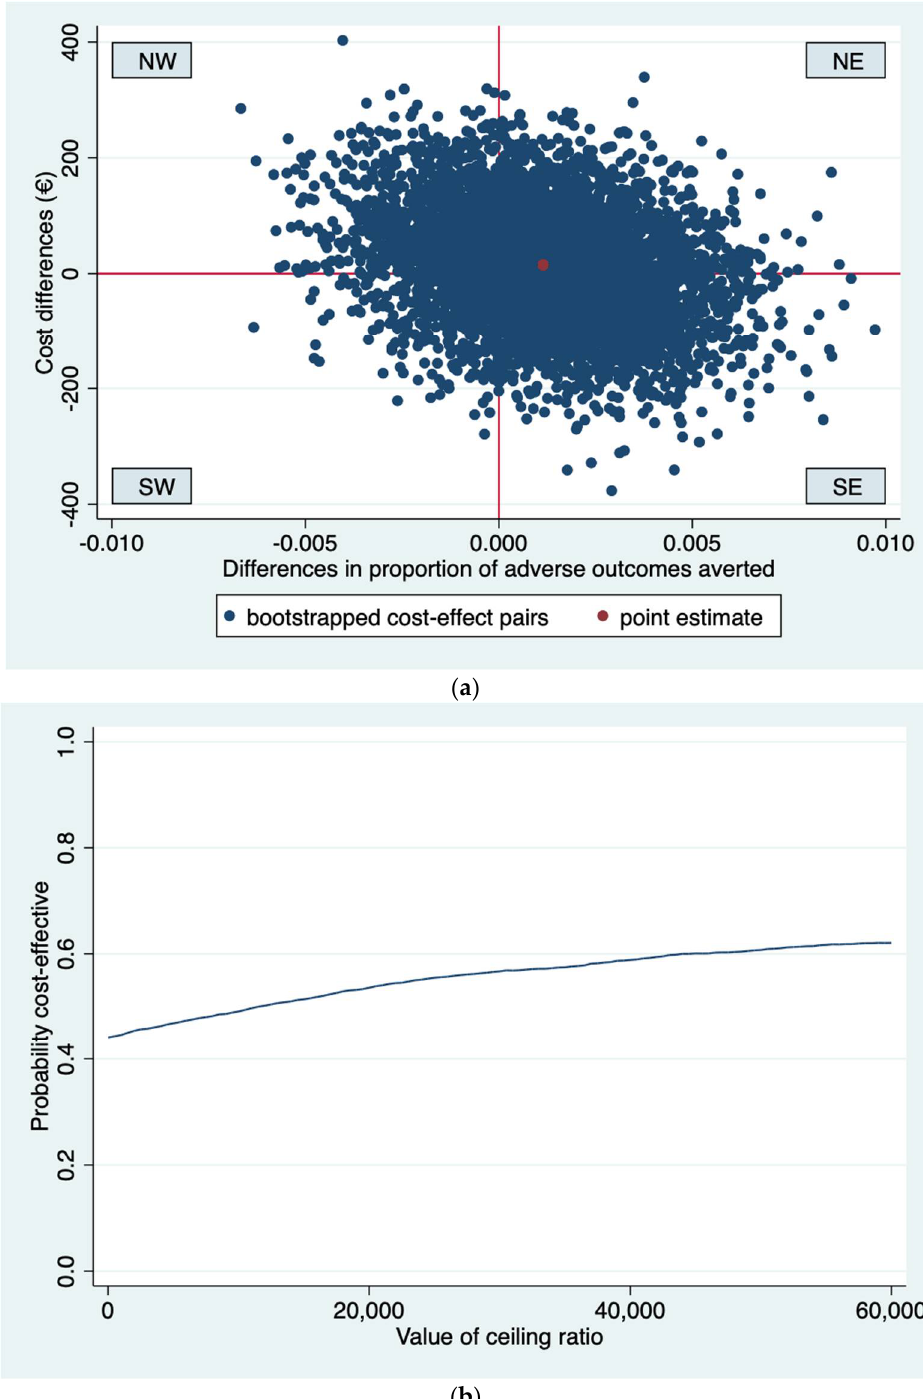
Figure 2. ( a ) Cost-effectiveness plane for analysis 1 (time horizon one week after birth, adverse outcomes averted, Perined data only). The Northeast (NE) quadrant indicates that routine ultrasonography is more effective and more costly than usual care. The Southeast (SE) quadrant indicates that routine ultrasonography is more effective and less costly than usual care. The Southwest (SW) quadrant indicates that routine ultrasonography is less effective and less costly than usual care. The Northwest (NW) quadrant indicates that routine ultrasonography is less effective and more costly than usual care. ( b ) Cost-effectiveness acceptability curve for analysis 1 (time horizon one week after birth, adverse outcomes averted, Perined data only). The y axis shows the probability that routine ultrasonography is cost-effective compared to usual care. The x axis shows the maximum amount of money that society is willing to pay to avert one adverse outcome.